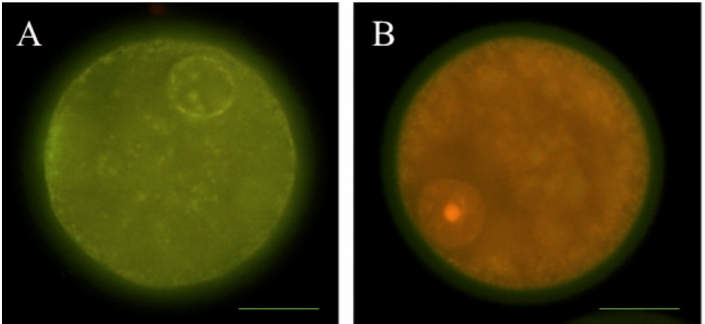
Figure 2. Representative images of DNA fragmentation by TUNEL assay in sheep oocytes at the germinal vesicle (GV) stage. ( A ) TUNEL-positive oocyte; ( B ) TUNEL-negative oocyte. Scale bar = 38 µ M.